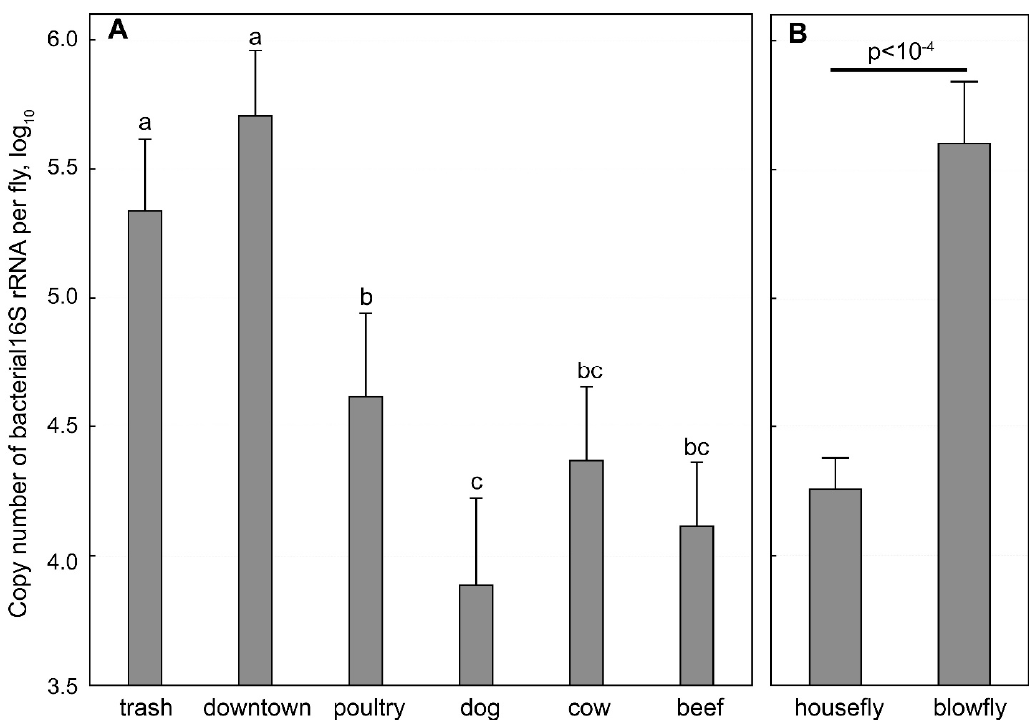
Figure 3. Copy number of bacterial 16S rRNA in flies based on qPCR.